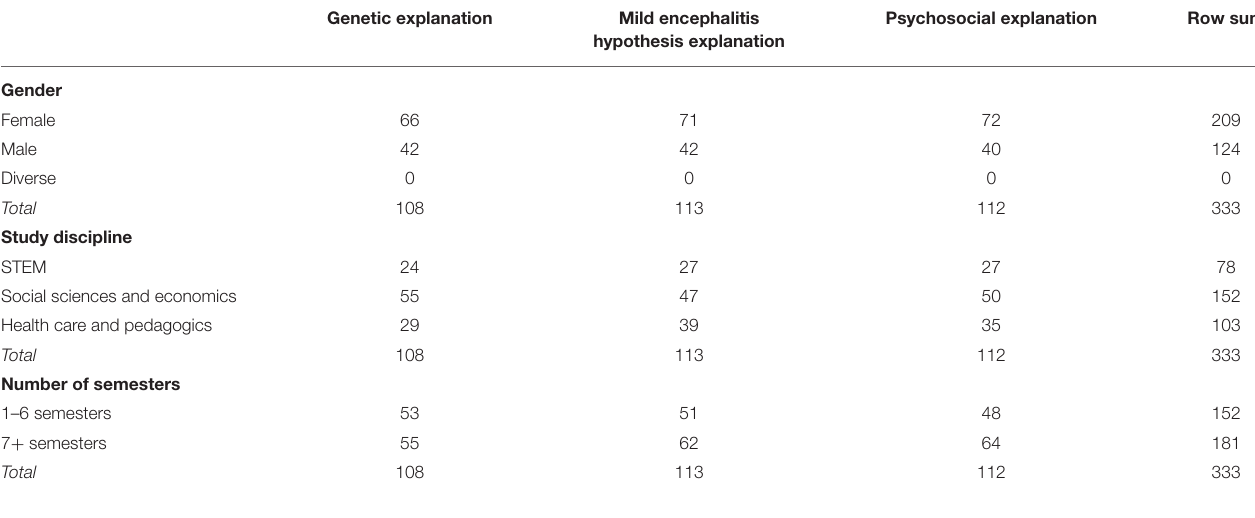
TABLE 1 | Comparison of baseline characteristics among the groups.